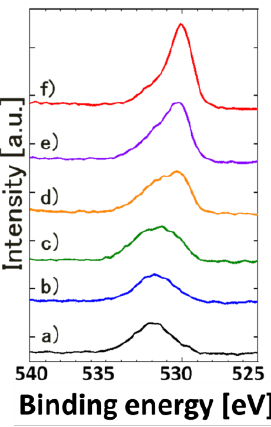
Figure 3. C 1s XPS spectra of Ti-DLC films before and after exposure to atomic oxygen. Fluences of atomic oxygen beam are ( a ) 0 atoms cm −2 , ( b ) 1.2 × 10 17 atoms cm −2 , ( c ) 1.2 × 10 18 atoms cm −2 , ( d ) 3.5 × 10 18 atoms cm −2 , ( e ) 1.2 × 10 19 atoms cm −2 , and ( f ) 1.9 × 10 20 atoms cm −2 .